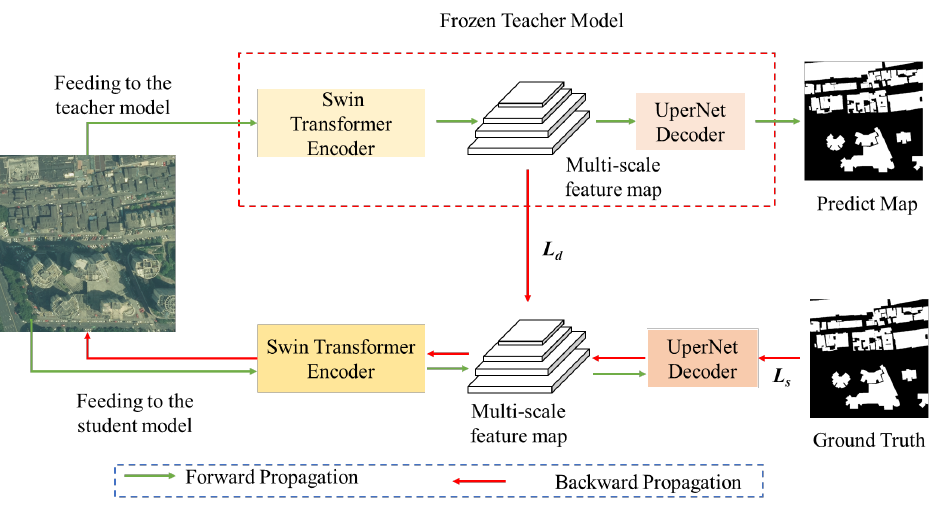
Figure 4. General structure diagram. During the training process, the parameters of the teacher model are frozen, and only the parameters of the student model are updated. Only the student model parameters must be used in the prediction